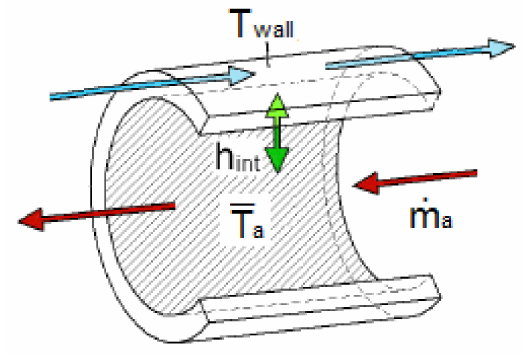
Figure 16. Heat exchanger